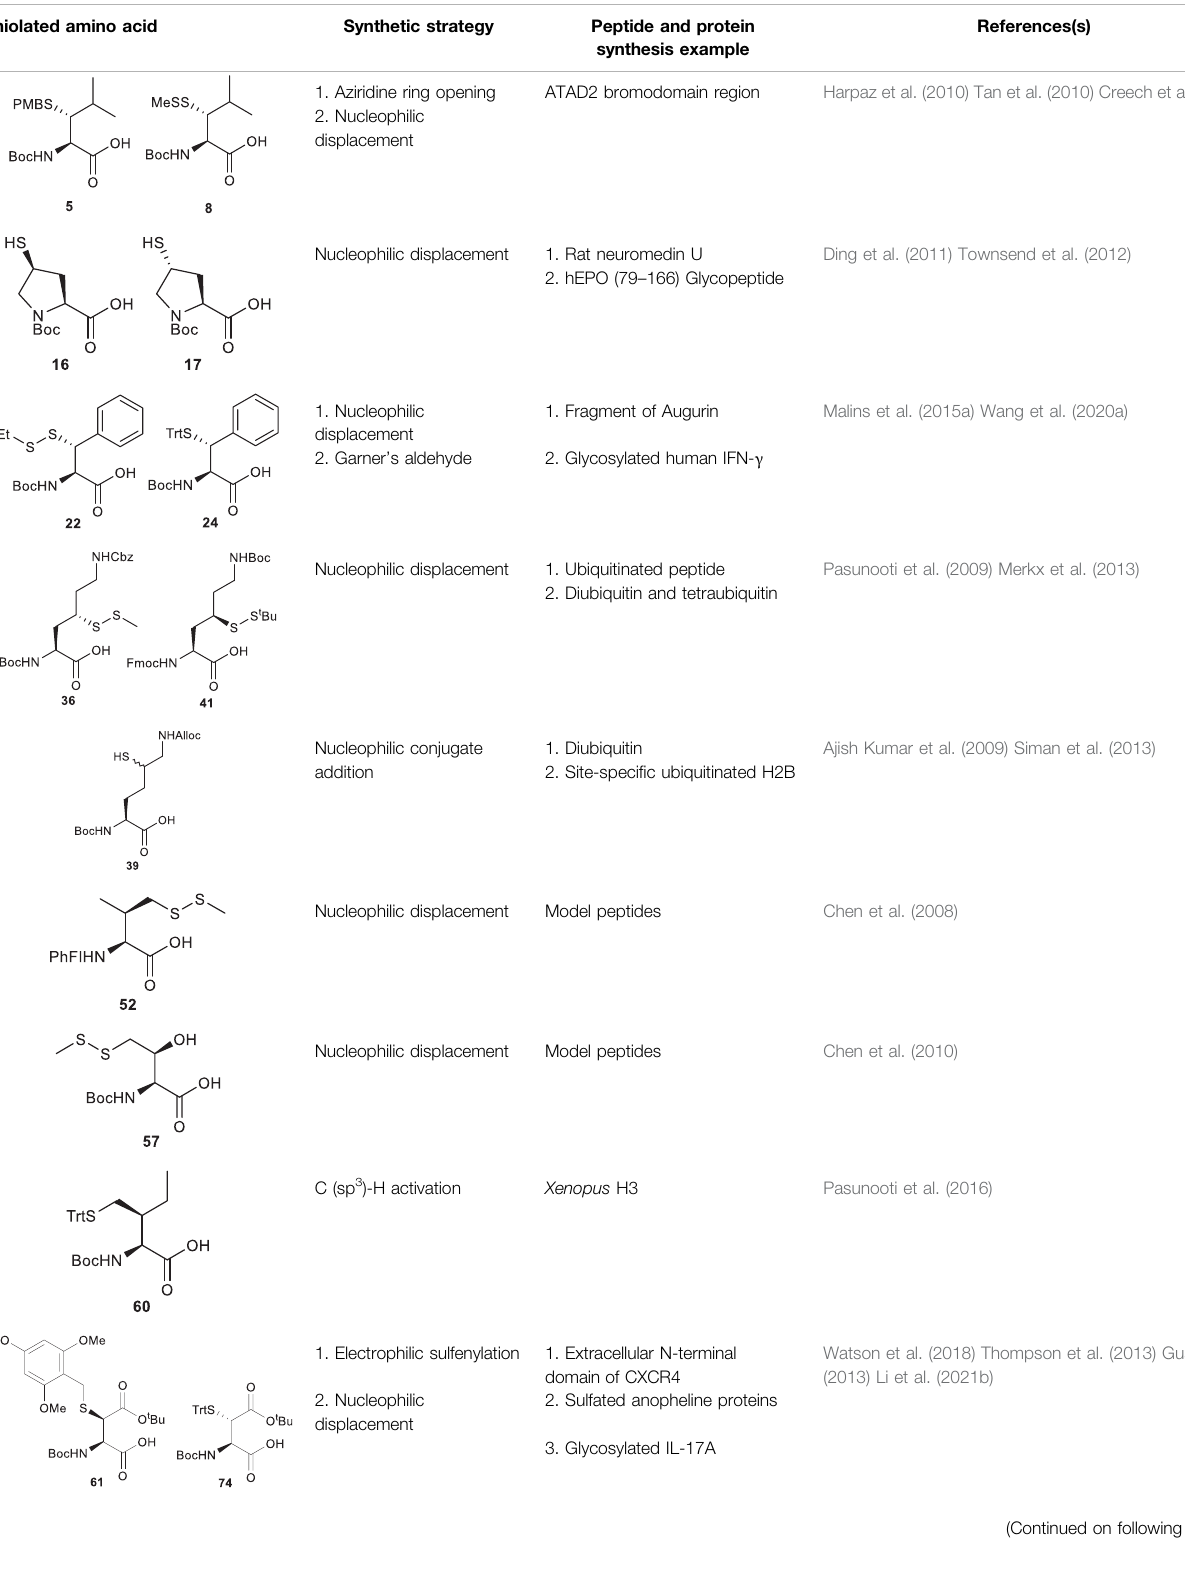
TABLE 1 | Thiol derived amino acids and the relevant synthesis examples described in this